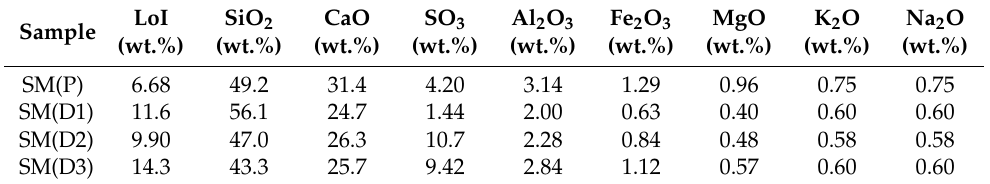
Table 1. Chemical composition of the raw materials determined by XRF. Loss of ignition =